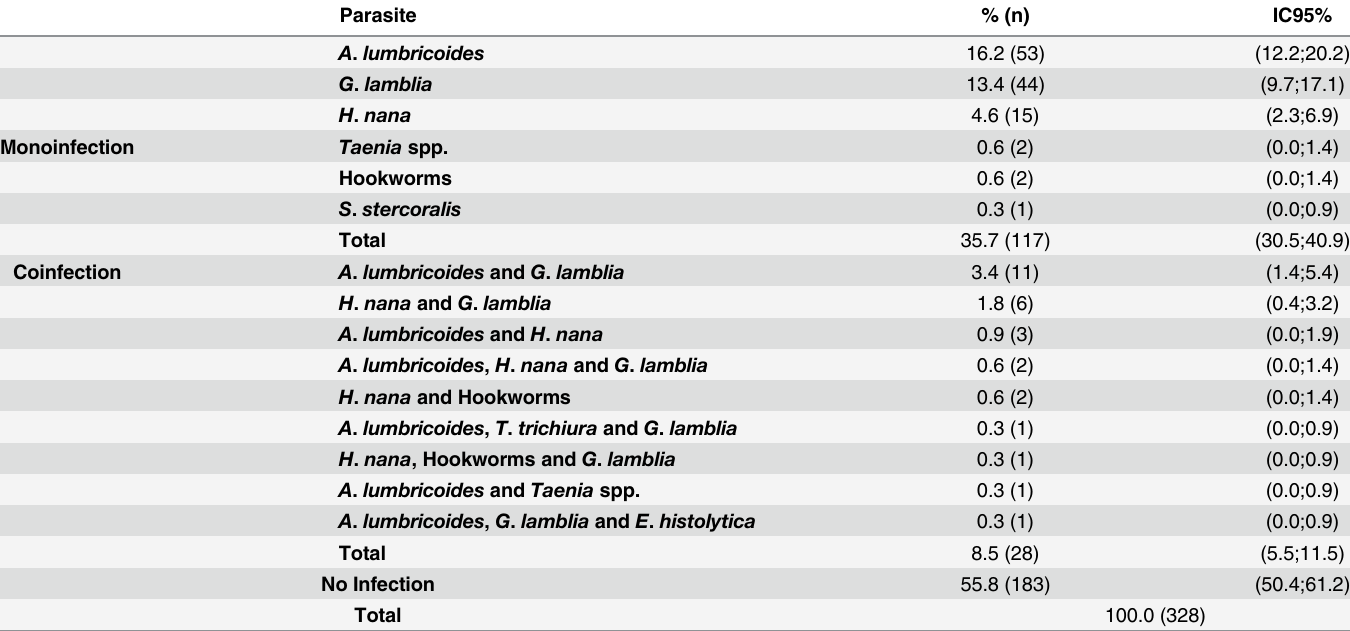
Table 2. Type of infection by pathogenic intestinal parasite: relative frequencies (%), absolute frequencies (n) and confidence intervals of 95% (IC95%).